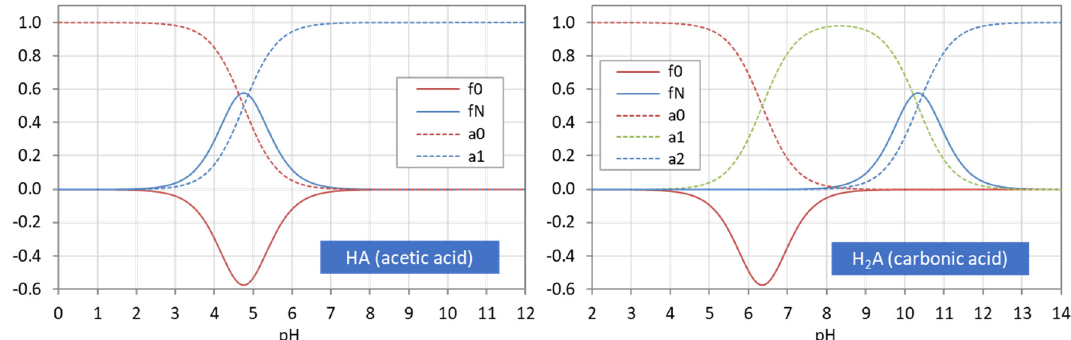
24 Figure 21. Micro- and macrostates of a triprotic acid and the corresponding (cumulative) equilib- rium constants. 2.5.3. Probability Distributions and Averages The two ionization fractions associated with the two reference states, a 0 and a N , are distinguished from all others by having a sigmoidal (S-shaped) curve, as discussed in Sec- tion 2.1.4. Their asymptotical values for pH = ± ∞ are 0 and 1, so that a 0 and a N embody cumulative distribution functions which gives the area under the probability density functions f 0 and f N :